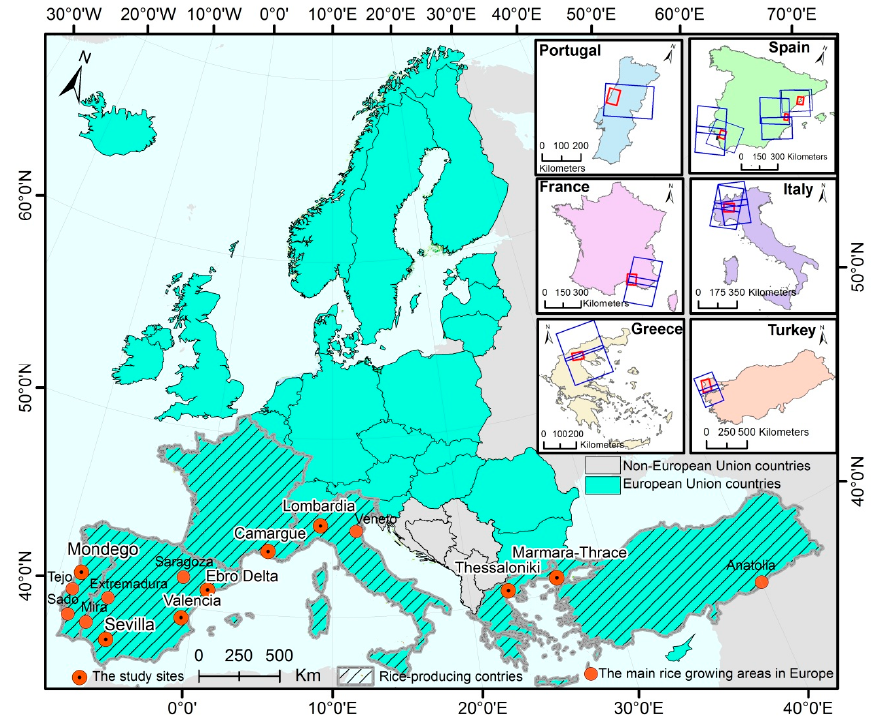
Figure 2. Study sites (red) and spatial extent of the used S-1 scenes (blue).